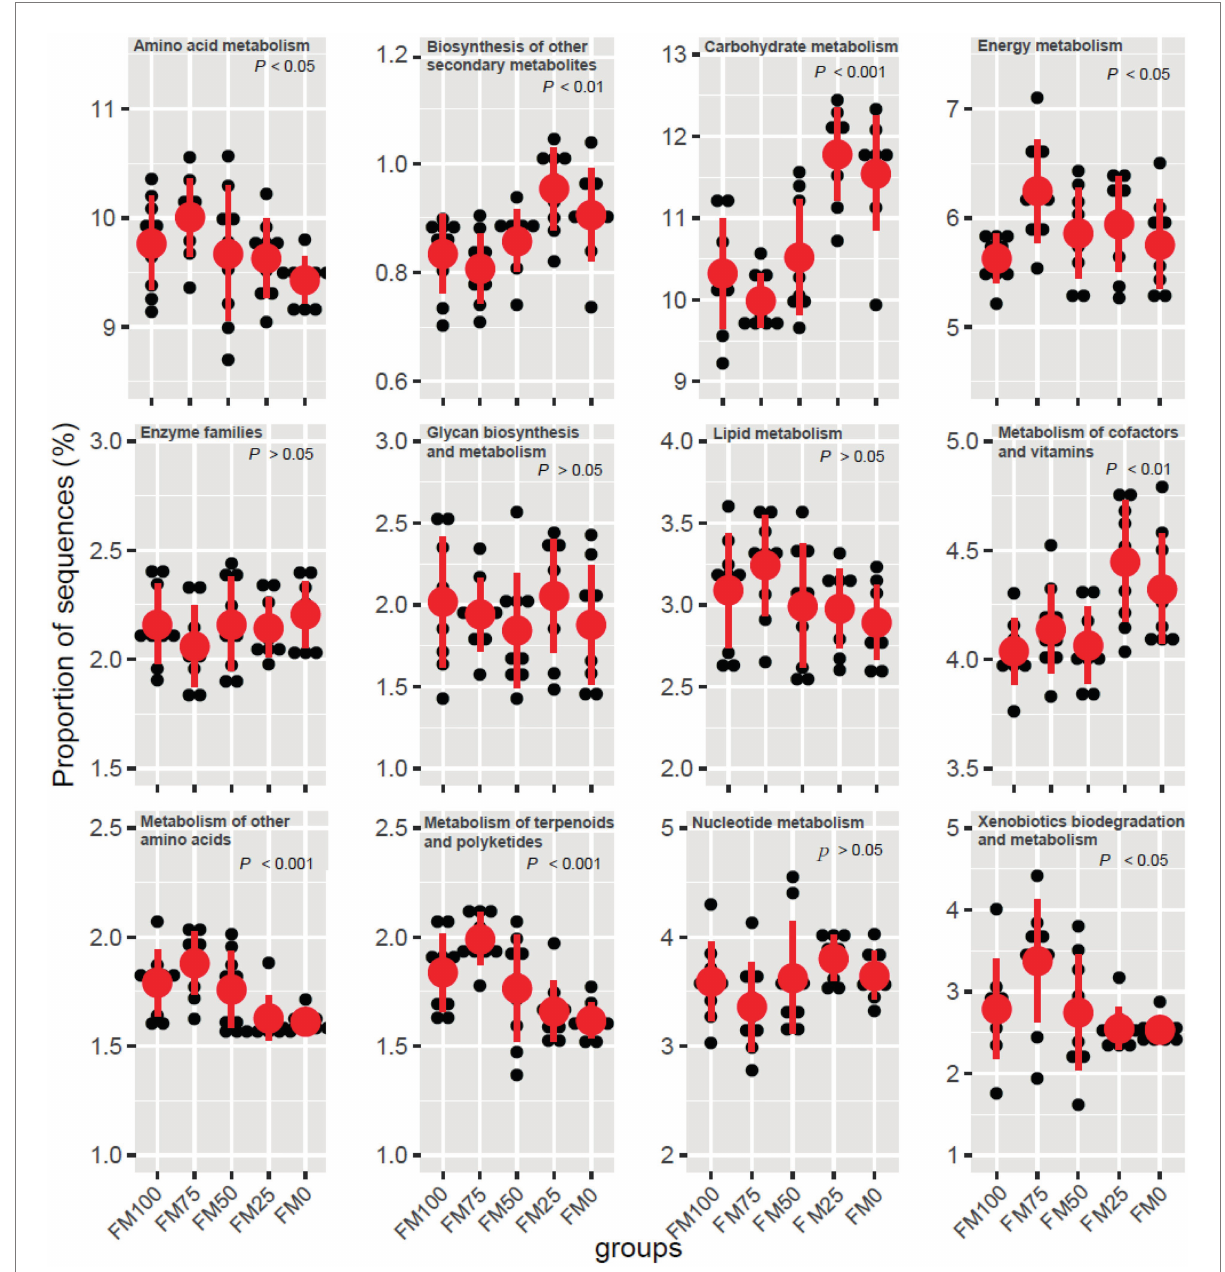
FIGURE 6 Functional metabolism analysis of KEGG pathways in gut microbial communities from the five groups of largemouth bass fed with different levels of Chlorella meal diets. FM100 represents the fishmeal diet without Chlorella meal; FM75, FM50, FM25, and FM0 represent the fishmeal feed with 25, 50, 75, and 100% fishmeal replacement by Chlorella meal,